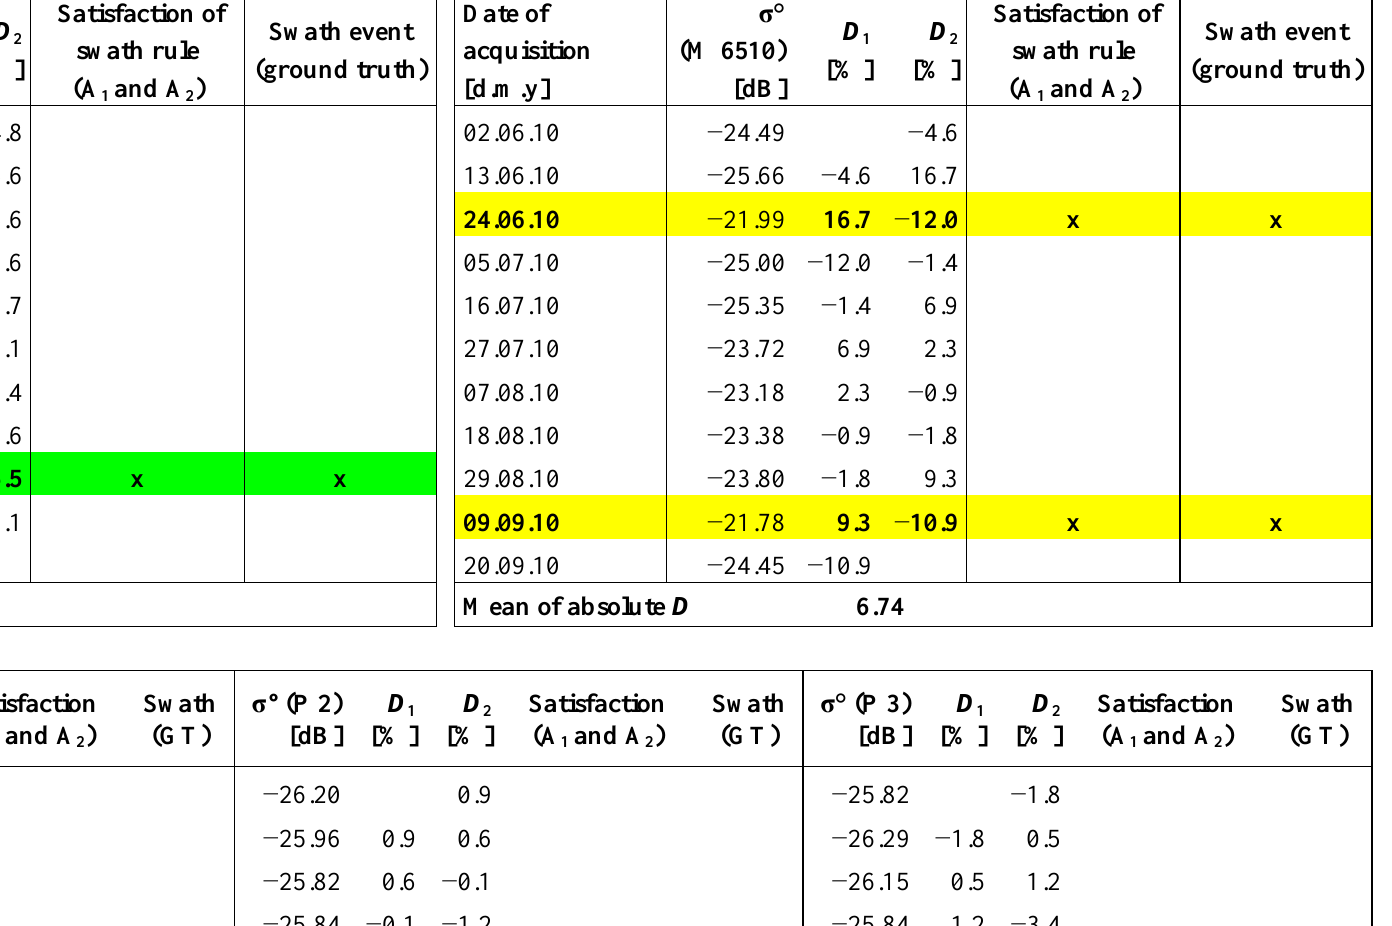
Table 1. Results for the detection of swath event induced peaks based on the proposed detection rule (satisfaction of A to swath events known from ground truth. One event is returned for Meadow 6410 (highlighted in green) and two for Meadow 6510 (highlighted in yellow). None is detected for the pasture